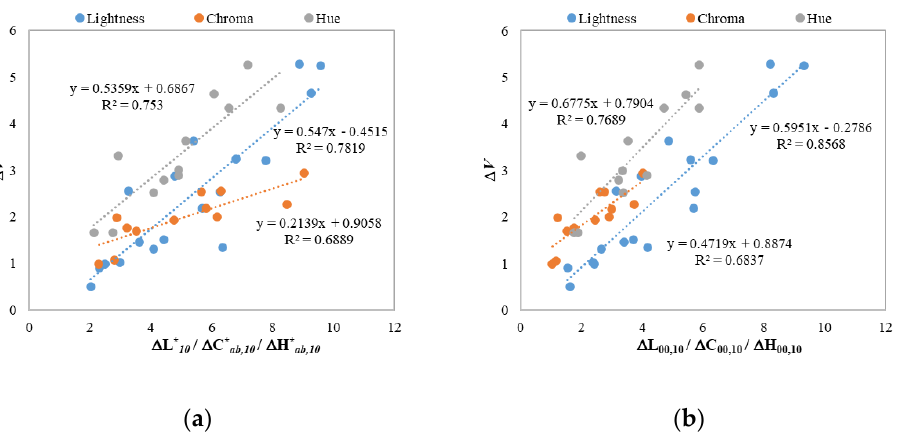
, ∆ C ∗ , ∆ H ∗ ( a ) and ∆ L 00 , ∆ C 00 , ∆ H 00 ( b ) of 10 ab ,10 ab ,10